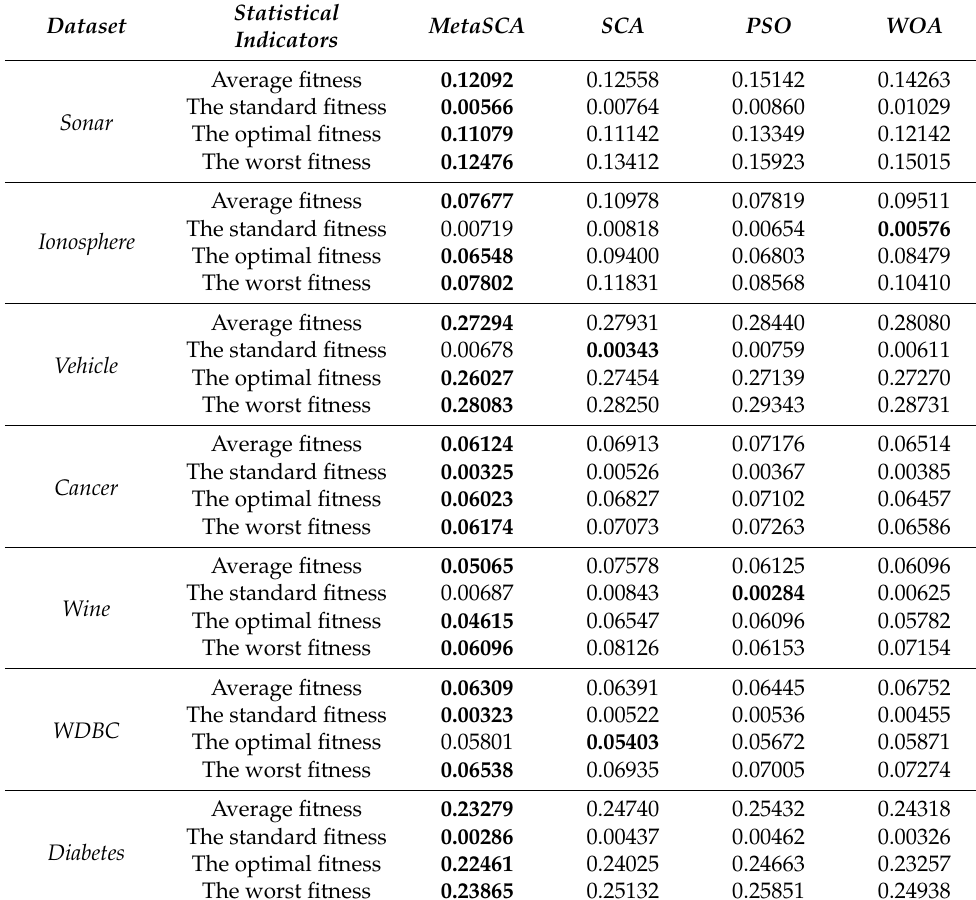
Table 4. Comparison of the MetaSCA and other methods in optimization of the fitness